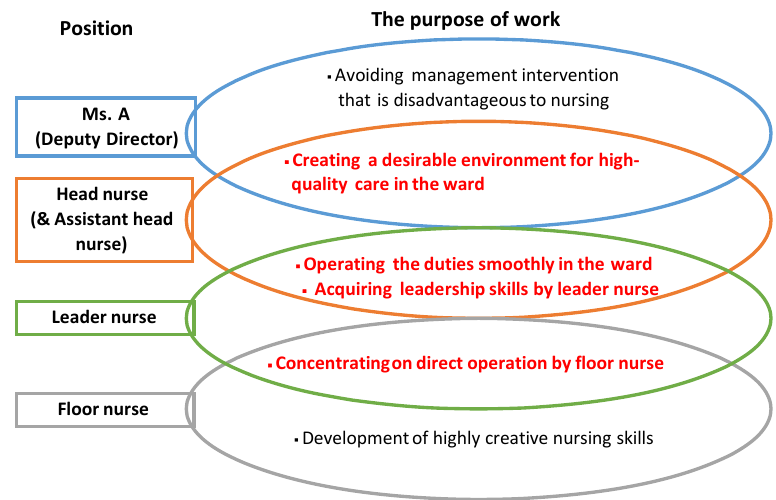
Figure 1. The purpose of work of each position staff